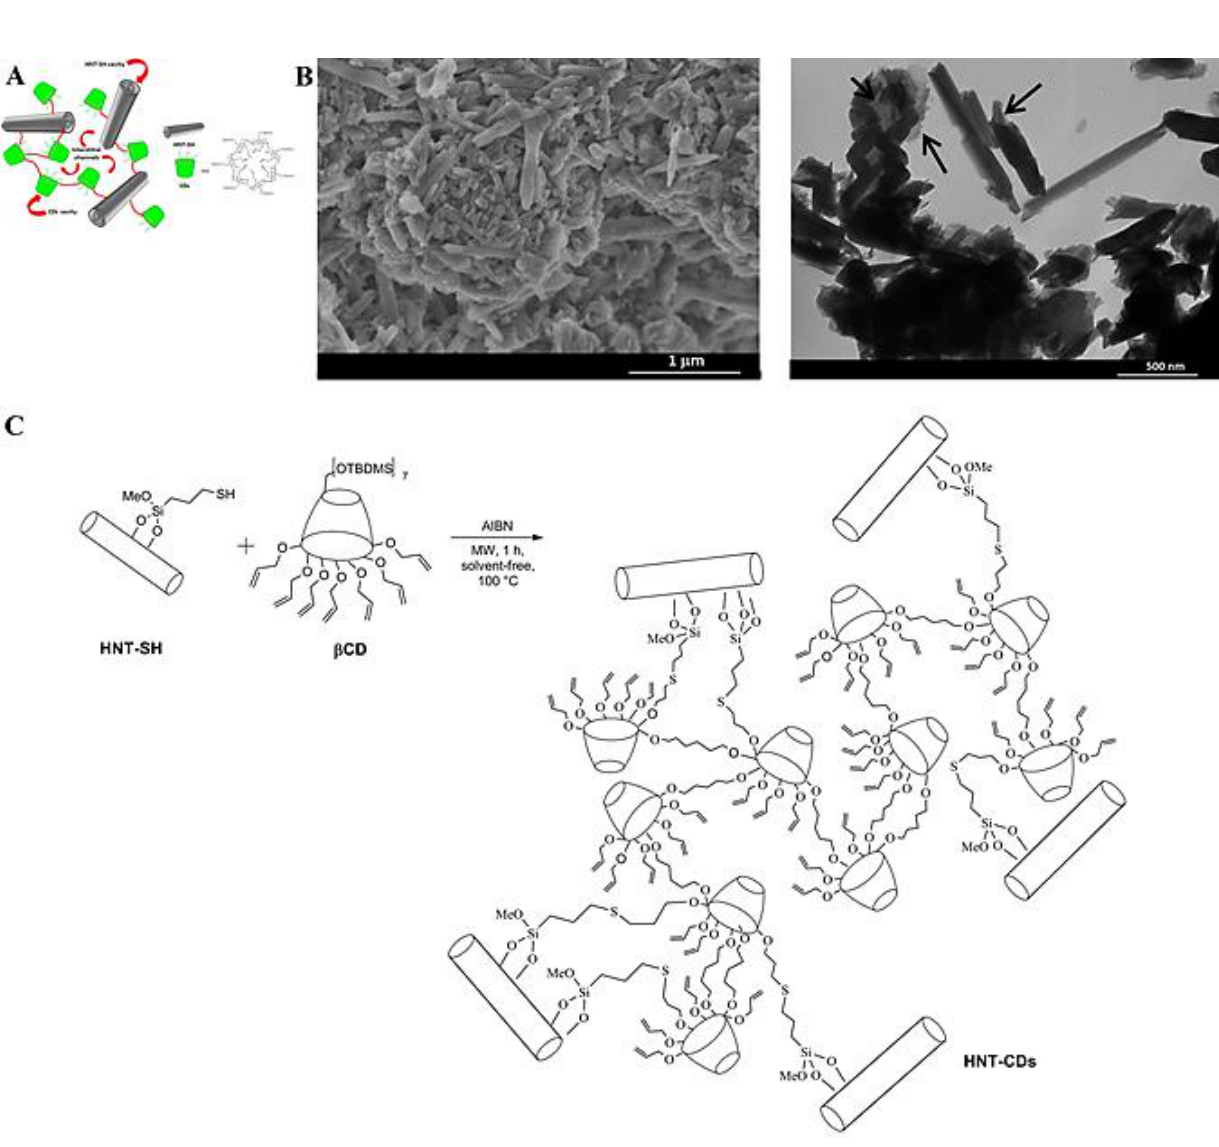
Figure 4. ( A ) Halloysite nanotubes (HNT)-cyclodextrin derivatives (CDs) nanosponge hybrids. ( B ) Scanning electron microscopy (SEM) and transmission electron microscopy (TEM) images of the designed nanosponge hybrids. ( C ) The preparative process of HNT-CDs nanosponge hybrids. Adapted with permission from Ref. [54]. Copyright 2017, American Chemical